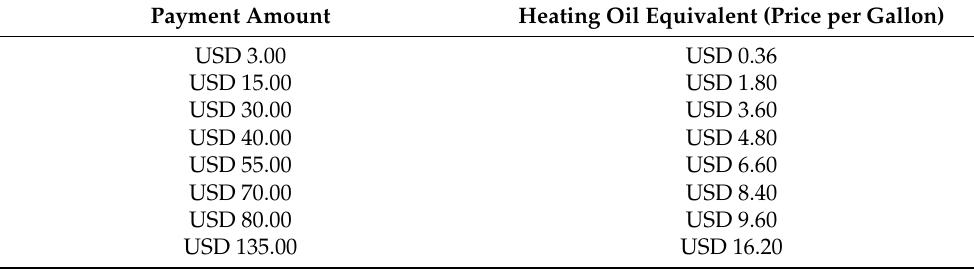
Table 1. Heating Oil Cost Equivalent for Payments